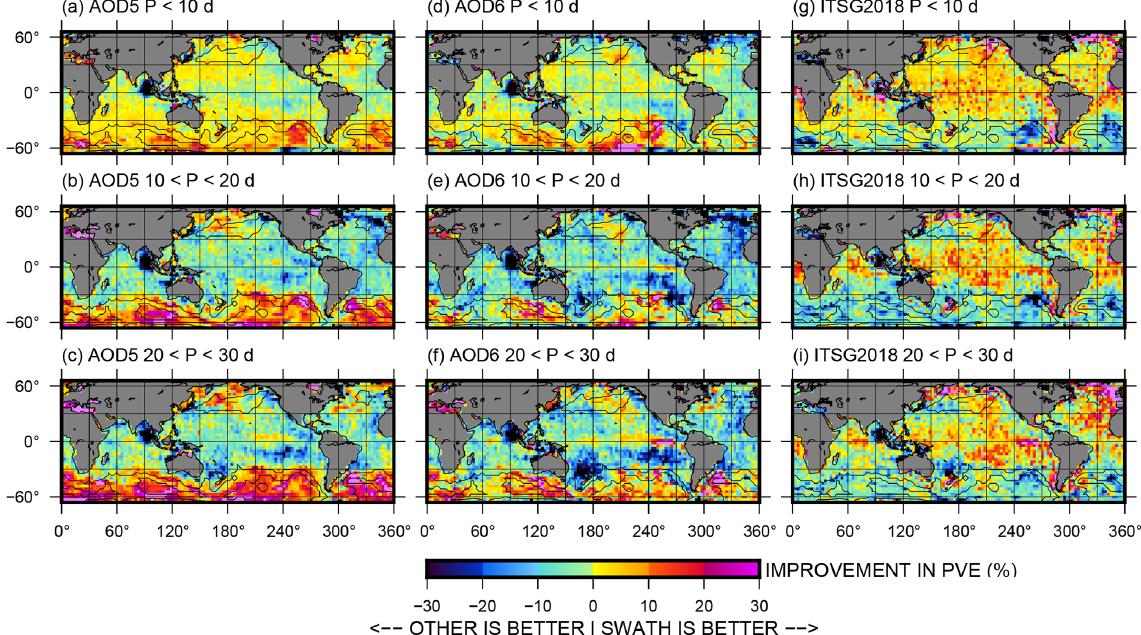
Figure 7. Differences in PVE for CSR swath vs. another data type per frequency band: (a, b, c) AOD5 de-aliasing ocean model, (d, e, f) AOD6 de-aliasing ocean model, and (g, h, i) ITSG2018 GRACE data. Panels (a, d, g) give the highest sub-monthly frequency band, while panels (c, f, i) give the lowest sub-monthly frequency band. Values are relative to CSR swath PVEs, so positive numbers (red) denote that the CSR swath matches altimetry better, while negative numbers (blue) denote that the other series matches altimetry